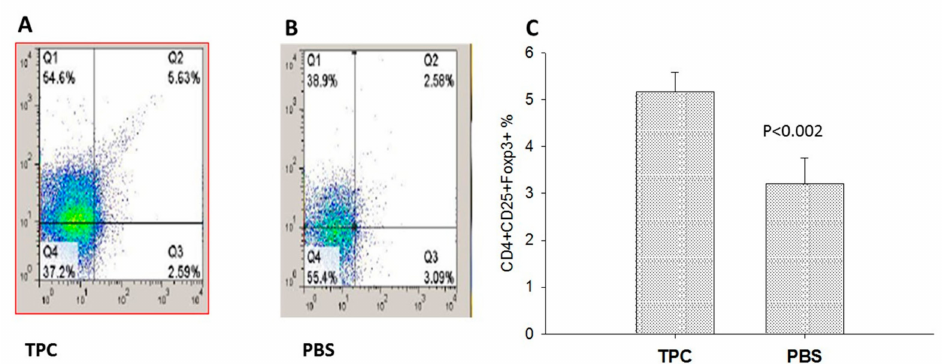
Figure 5. T regulatory cells expansion in isolated mesenteric lymph nodes of TPC-treated chronic colitis mice. ( A ). The data is presented as a percentage of Tregs CD4 + CD25 + FOXP3 + expansion in isolated mesenteric lymph nodes of TPC and PBS-treated mice (n = 20). Values are the mean ± SD, p < 0.0001. ( B ) Representative flow cytometry analyses of Tregs CD4 + CD25 + FOXP3 + (gated on CD4 + ) in mesenteric lymph nodes derived from the TPC and PBS-treated mice. TPC—5.63% PBS—2.58%. ( C ) Percentage of T regulatory upon treatment with TPC in comparison to treatment with PBS.